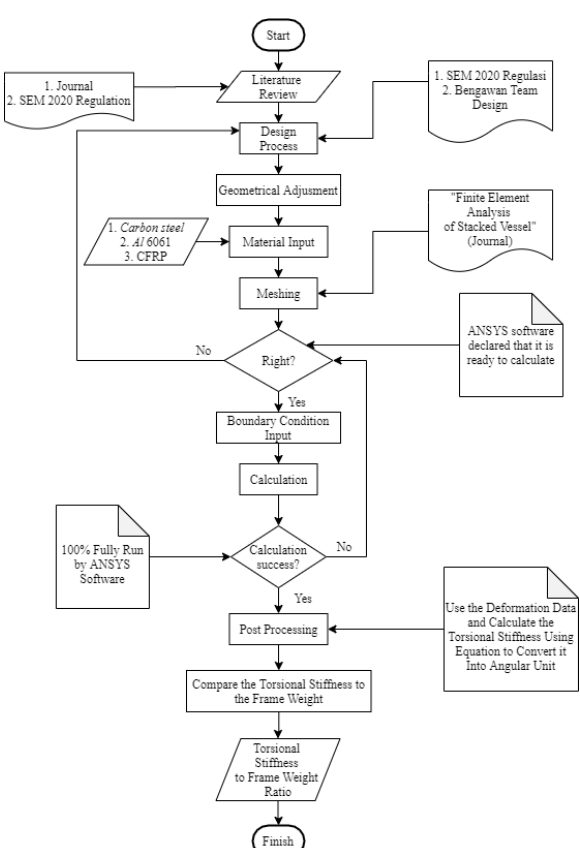
Figure 7: Research flow